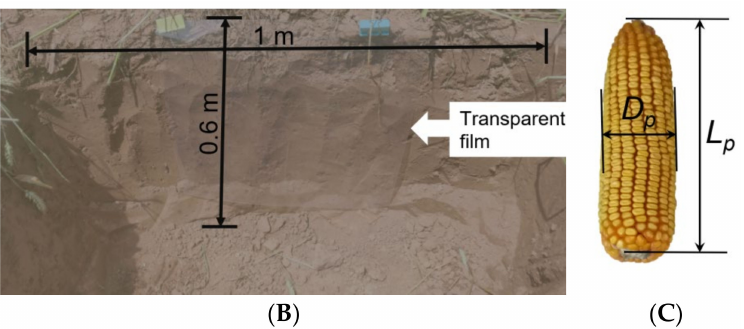
Figure 3. The parameters of soil disturbance and crop growth: ( A ) The disturbance area of top layer ( A t ) and hardpan ( A h ); ( B ) Measurement of wheat root distribution; ( C ) Length ( L p ) and diameter ( D p ) of maize